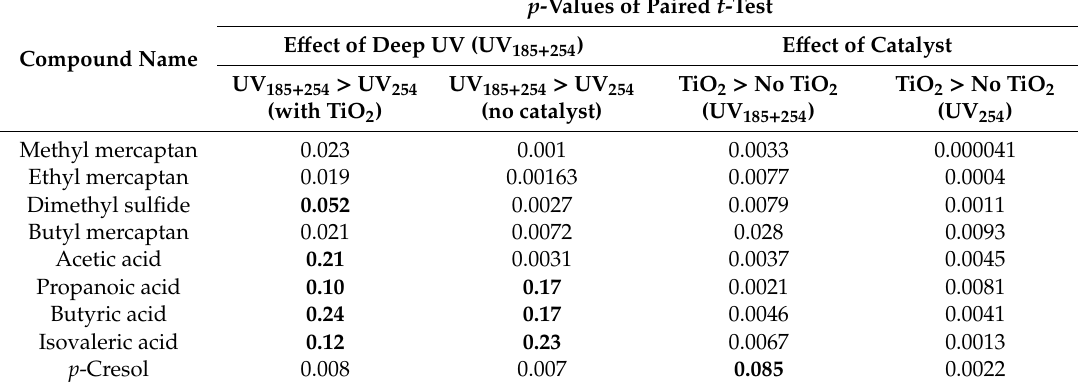
Table 1. Statistical analyses. E ff ects of UV wavelength and catalyst on treatment e ff ectiveness (expressed as R ). The table represents p -values of paired t -tests. Bold fonts indicate no statistical significance ( p ≤